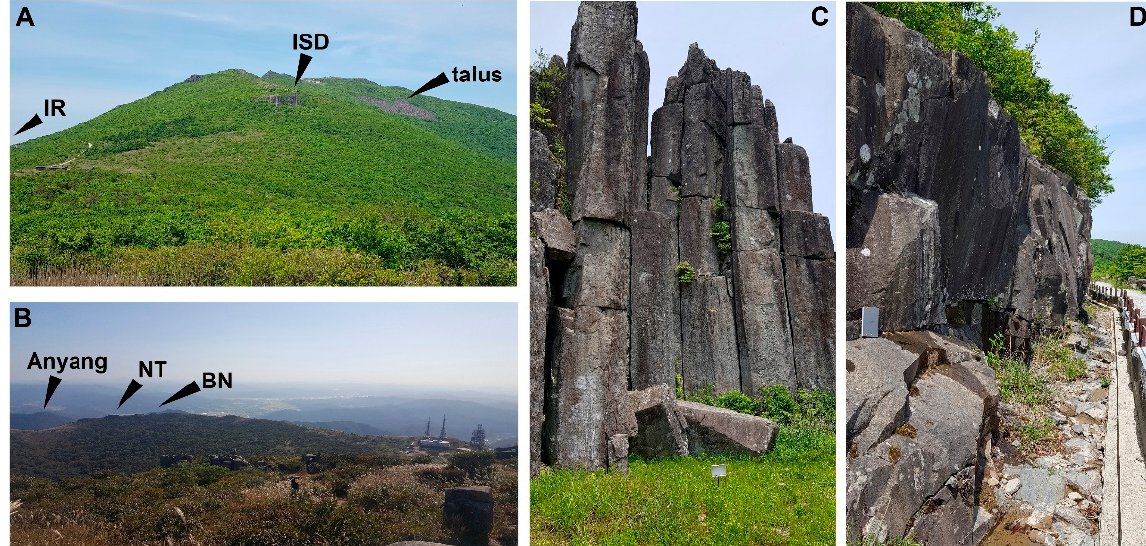
Figure 2. ( A ) Ipseokdae rock (ISD) and talus that was formed by the collapse of columnar joints are shown. Ice rock (IR) is located beyond the scope of this photo. ( B ) Baekma ridge (BN), Nakta peak (NT), and Anyang peak. (Anyang). BN is the ridge of the mountain. ( C ) Close ‐ up view of ISD. ( D ) View of IR. This was observed along the trail.